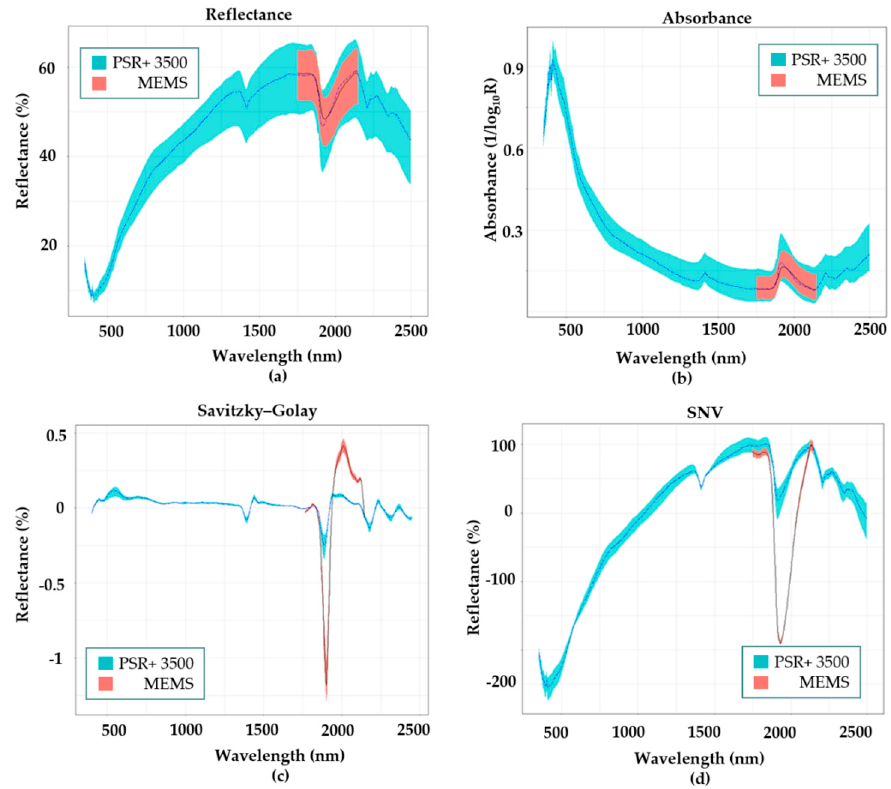
Figure 4. ( a ) Median reflectance measurements of complete dataset with PSR+ 3500 (with blue) and MEMS (red) ranging from first to third quartile. ( b ) Absorbance transformation. ( c ) First derivative transformation combined to third degree polynomial fitting. ( d ) Standard Normal Variates normalization.